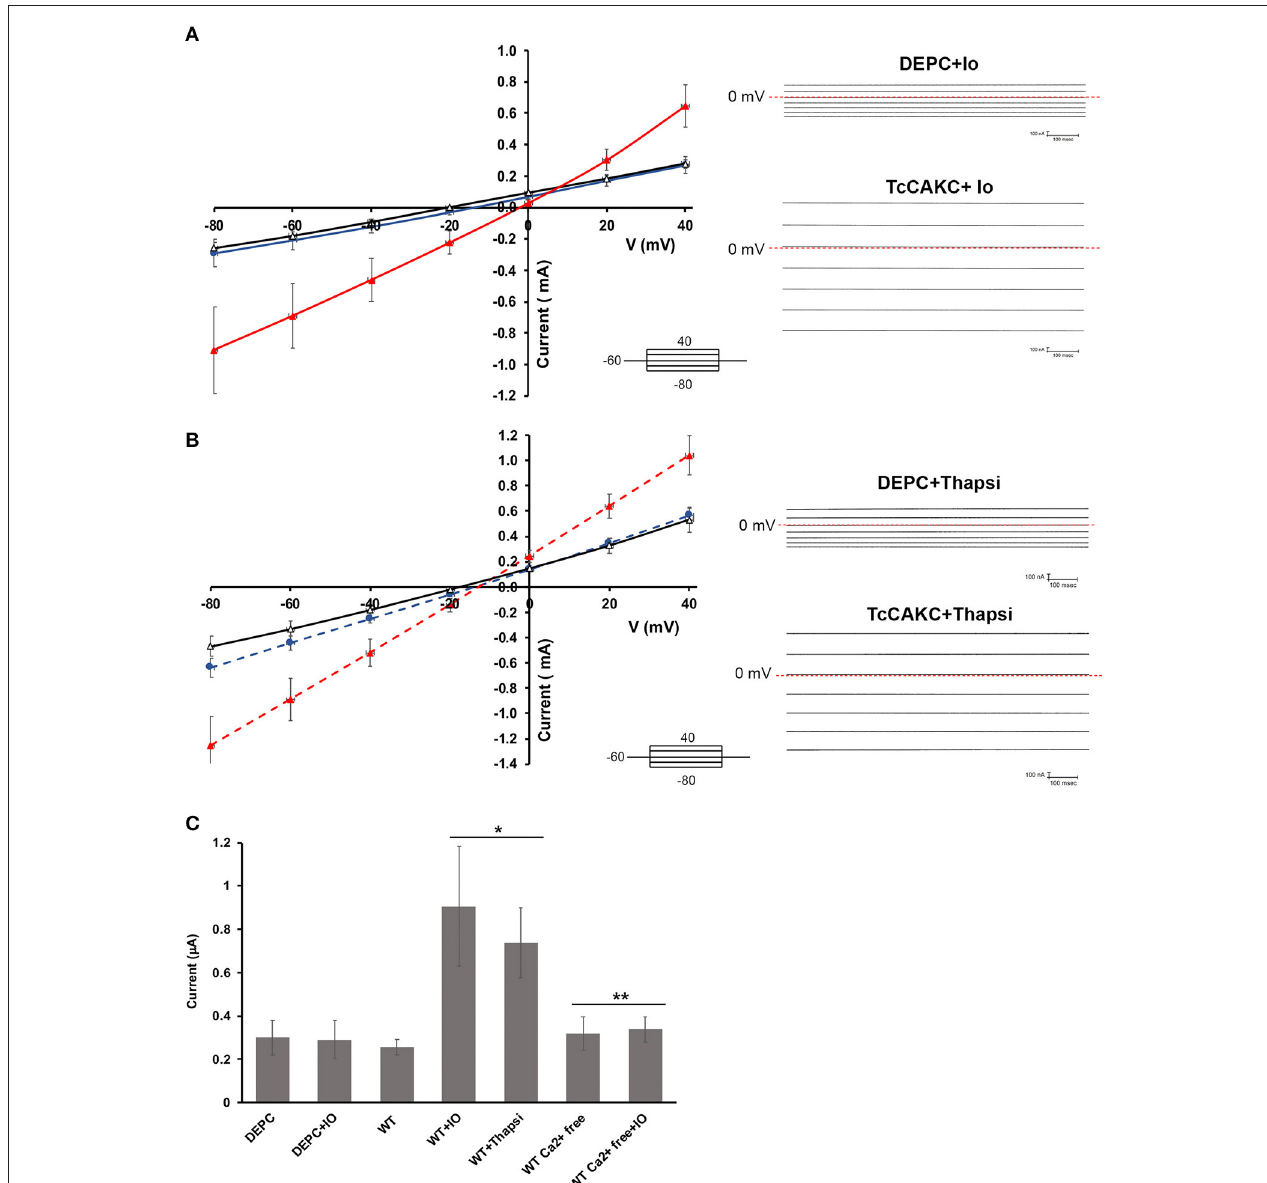
FIGURE 2 | Electrophysiological characterization of TcCAKC . (A) Current-voltage relationship of oocytes expressing TcCAKC in the absence (black) or presence (red) of 1 µ M ionomycin. Control currents are obtained from oocytes injected with DEPC water and treated with 1 µ M ionomycin (blue line). Representative traces are shown in the right panel. Values are Mean ± SD of n = 18 oocytes. (B) Current-voltage relationship of oocytes expressing TcCAKC (red) or control (blue) preincubated with thapsigargin ( n = 15). TcCAKC currents in absence of thapsigargin are indicated in black. Representative traces are shown in the right panel. All recordings are in ND-96 buffer with a holding potential of − 60 and 20mV step protocol between − 80 and 40mV. (C) Maximum currents at − 80mV (in absolute values) for oocytes under the indicated conditions. Calcium free conditions were achieved by addition of 1mM EGTA in ND 96 buffer without added CaCl 2 . Values are Mean ± SD of n = 15 oocytes. * p < 0.01 respect to the WT, ** p < 0.01 respect to the corresponding condition without